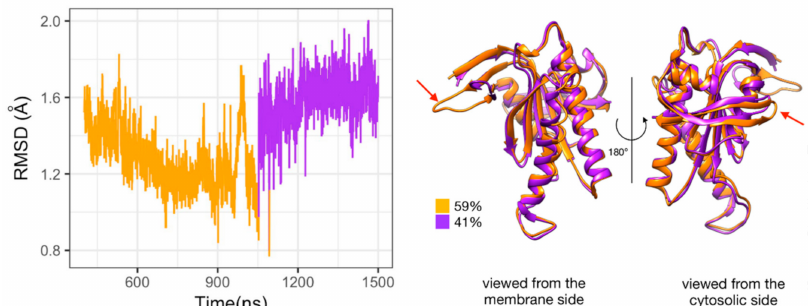
Figure 5. Substates of domain C2 observed during the simulation of G α i_sym + AC5 + ATP complex. Left side: Root mean square deviation (RMSD) time series for the C2 domain, colored according to cluster membership. Right: structures closest to the center of each cluster, and relative size of each cluster as percentages. Prominent structural changes are indicated by red